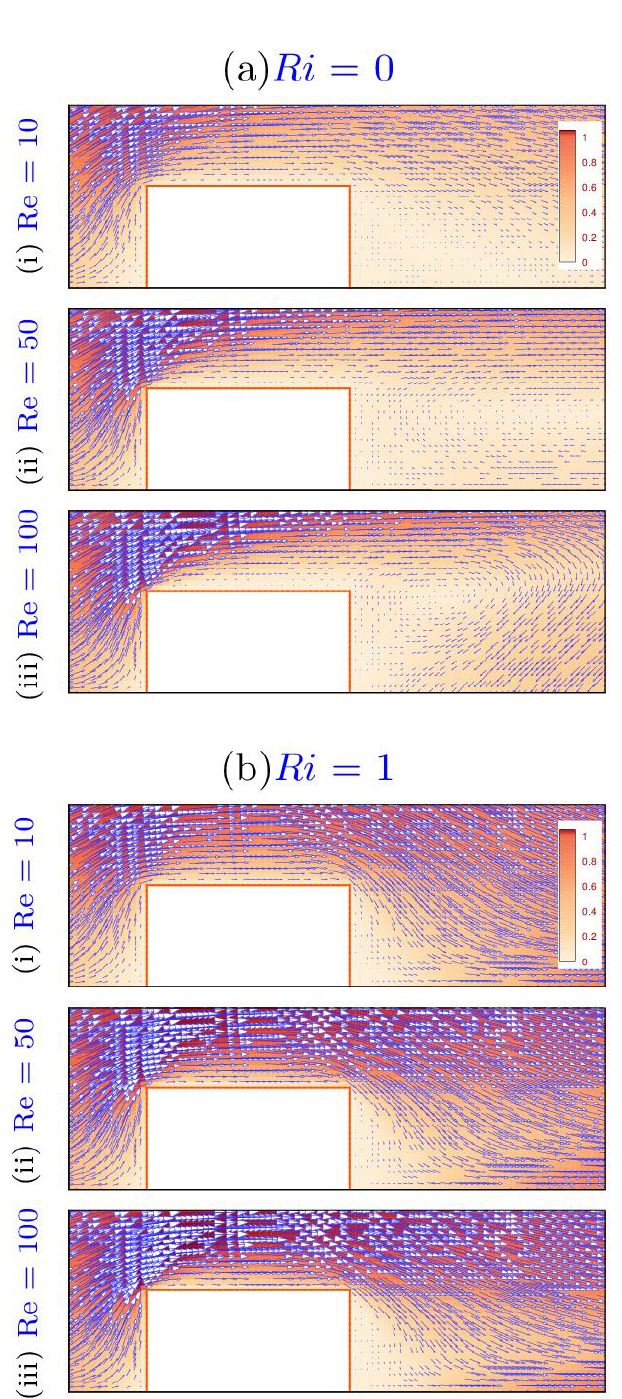
Figure 5. Velocity vectors and contours of velocity above a horizontal plane passing through the centre of the cylinder for different values of Re and Ri at φ = 5% : ( a ) Ri = 0 and ( b ) Ri = 1. Further, the downstream stretching of vorticity contours increases with Re at a fixed value of Ri . The magnitude of the vorticity near the surface of the cylinder increases with an increase in Re and/or Ri, as seen in Figure 6a,b. Further, the effects of thermal buoyancy on heat transfer are discussed in Section 5.2.1. Comparison of the results between single- phase and multi-phase approaches is shown through streamline plots and vorticity con- tours in Figure 7I,II at different values of Re and Ri . It is observed that the wake and vor- ticity patterns show qualitatively similar trends for both the approaches for the considered parameters.